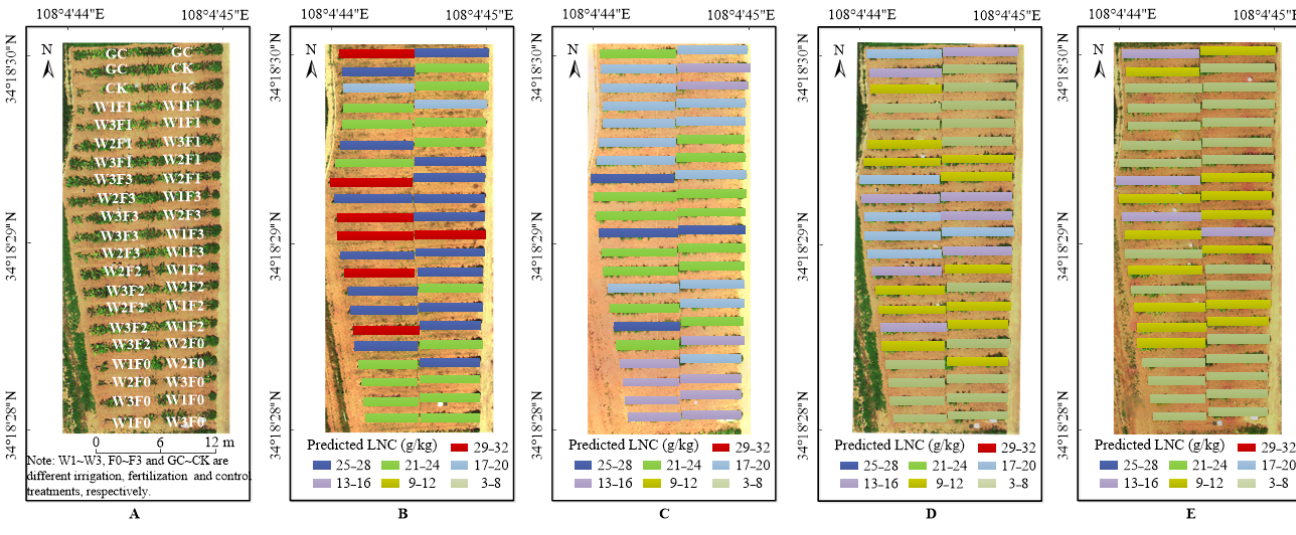
Figure 6. ( A ) Distribution map of grape with different treatments based on UAV image (22 June